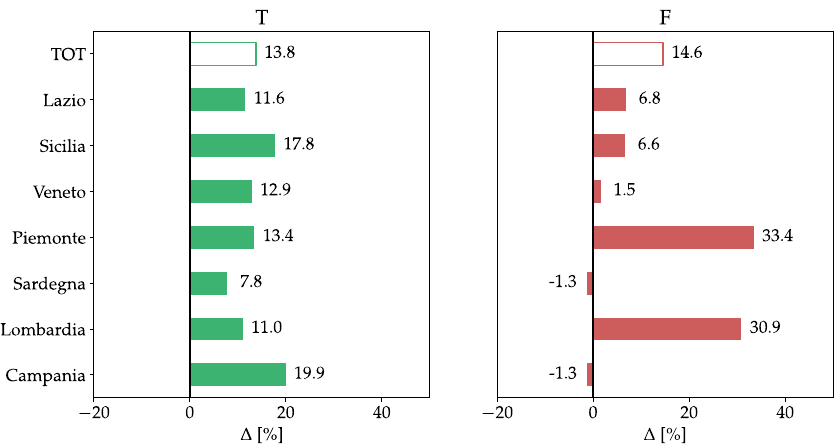
Figure 26. Percentage difference comparison between new and current criteria: IN Subset.